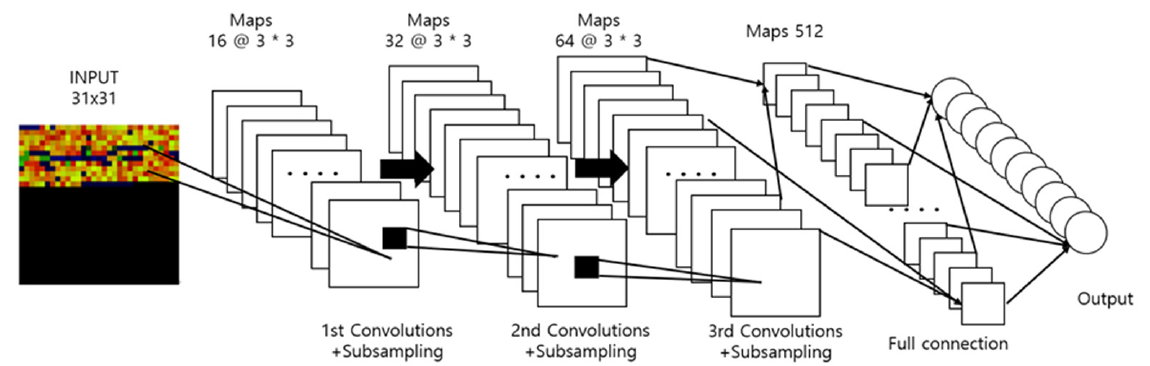
Figure 10. Illustration of the architecture of CNN 2D processing image data.